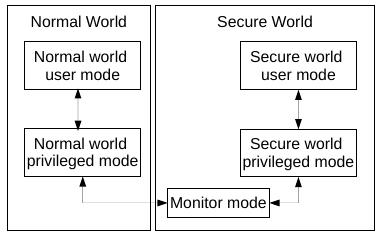
Figure 1. ARM TrustZone secure and normal